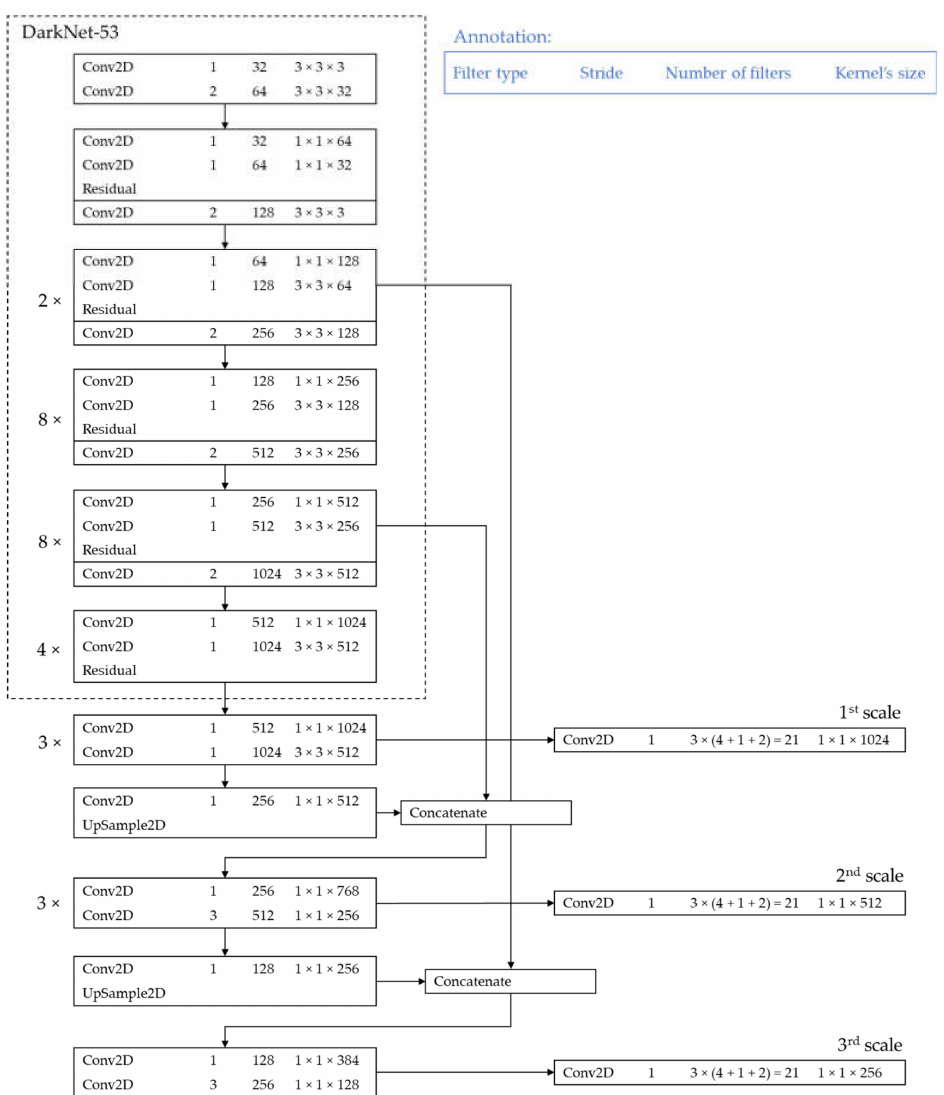
Figure 3. Architecture of YOLOv3 object detector. “Conv2D” and “UpSample2D” denote the two- dimensional convolutional layers and up-sampling layers,